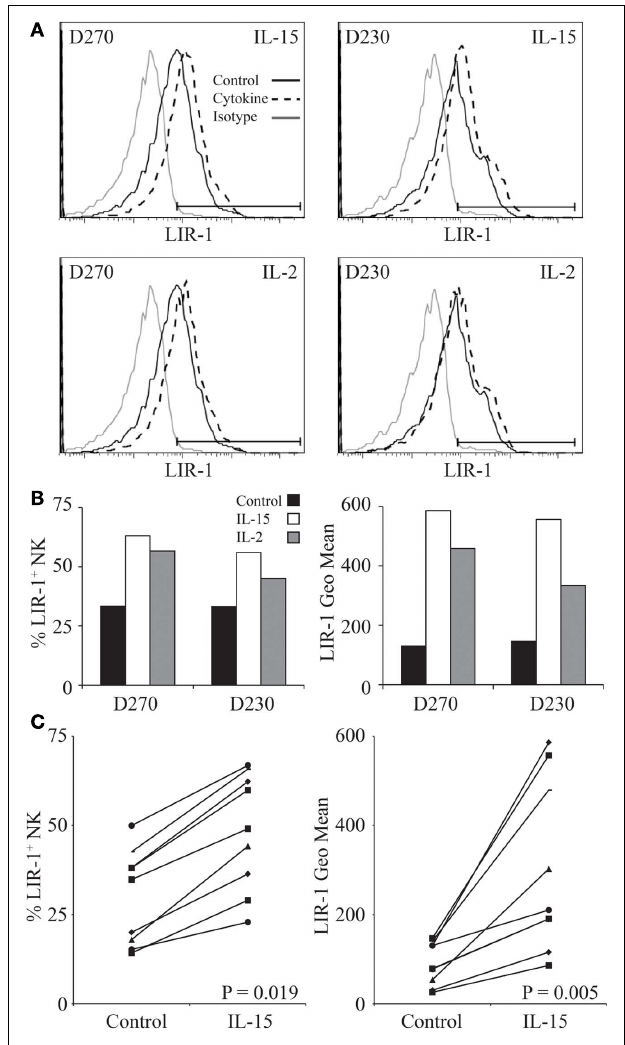
FIGURE 5 | IL-15 and IL-2 increase LIR-1 expression on purified NK cells. (A) NK cells were isolated from donor PBMC and stimulated ex vivo with IL-15, IL-2, or media alone for 72h and then examined for LIR-1 expression by flow cytometry. Representative histograms are shown for assays with D270 and D230. (B) The proportion of LIR-1 + NK cells and the geometric mean fluorescence intensity in each sample from the assays with D270 and D230 depicted in (A) with the background subtracted. (C) Changes in LIR-1 expression on NK cells stimulated with IL-15 are shown for various donors. The left panel shows changes in the frequency of LIR-1 + cells while the right hand panel shows the changes in the geometric MFI.The P -values are for the differences in the means between the stimulated and unstimulated